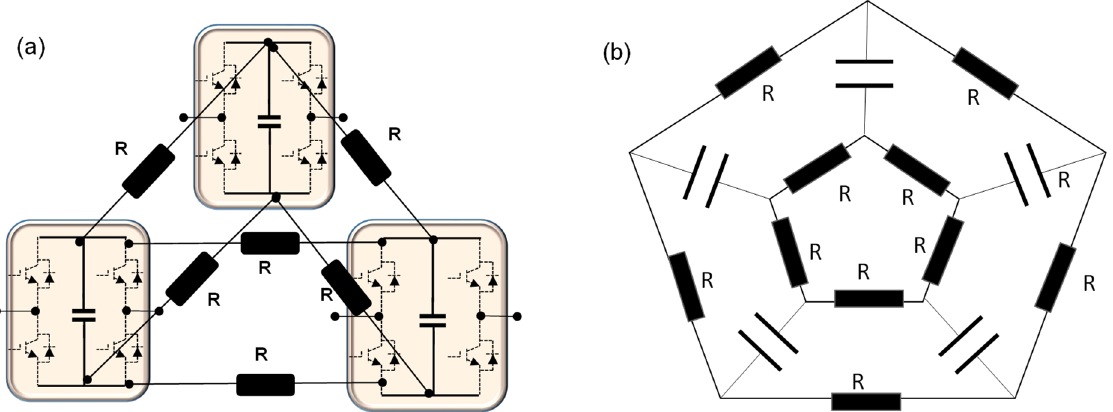
Figure 10. Resistive equalizer networks for three and five inverter networks. ( a ) Detailed three converters in paralleling; ( b ) Simplified view of five converters in